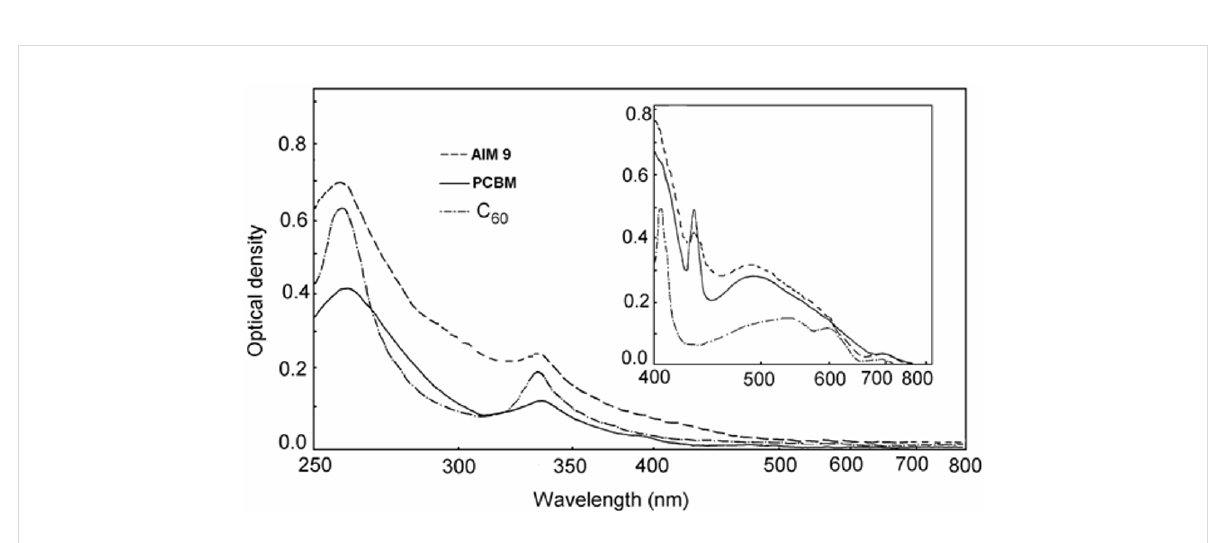
Figure 2: Optical absorption spectra of AIM 9, PCBM, and C 60 in CH 2 Cl 2 (2·10 − 5 mol·L − 1 , the cell thickness d = 2 mm). Inset shows the absorption spectra at d = 10 mm.